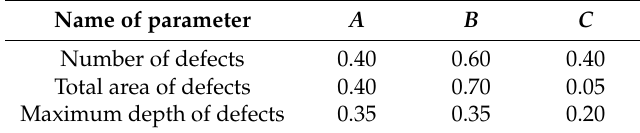
Table 4. Surface quality indexes of the experimental